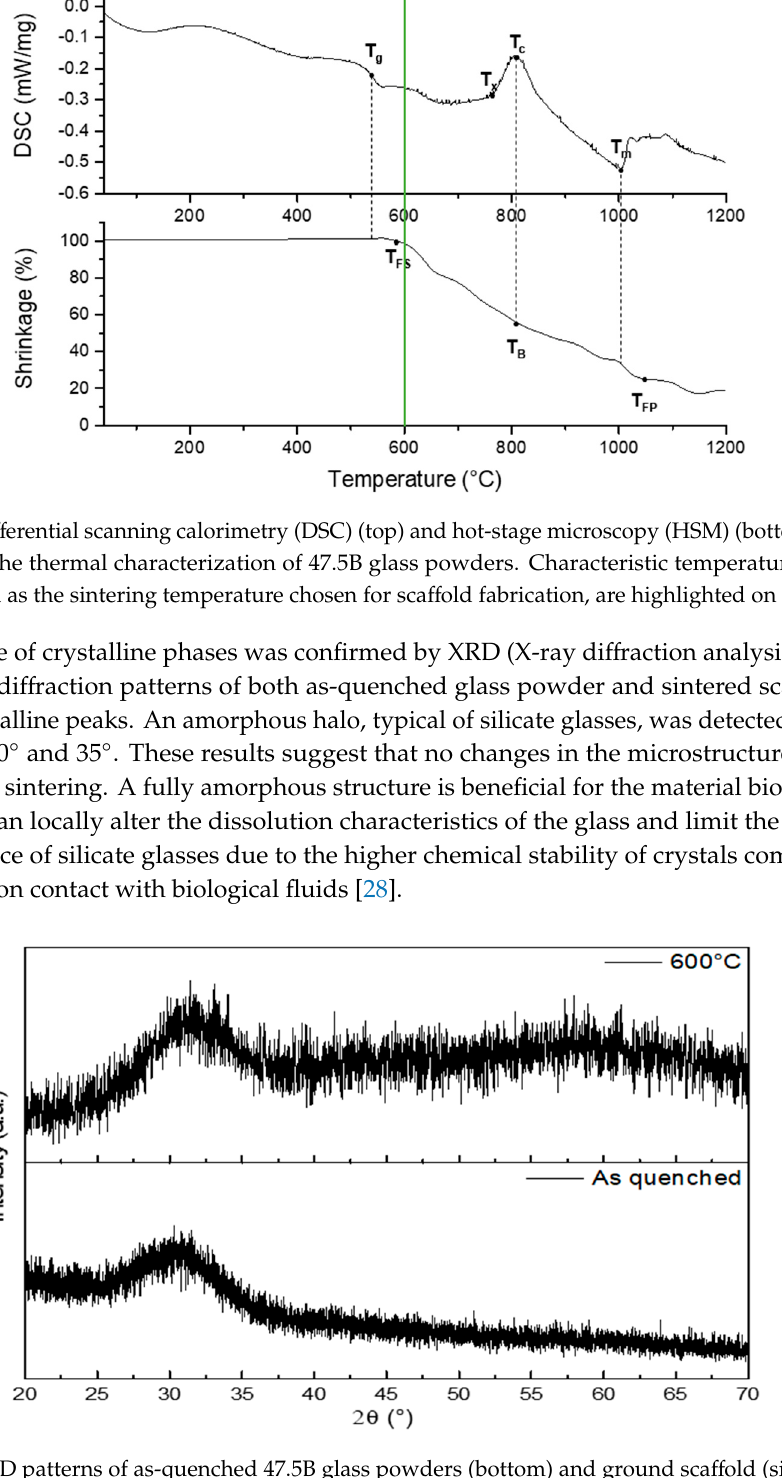
Figure 2. XRD patterns of as-quenched 47.5B glass powders (bottom) and ground scaffold (sintered at 600 °C for 1 h) (top). Both patterns are characterized by the glass amorphous halo.